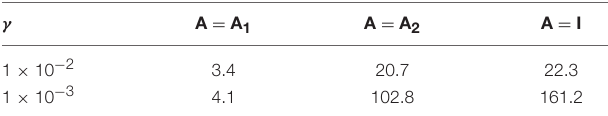
TABLE 1 | Effective sample size reduction ratio η for various choices of regularization parameter γ and acceleration matrix A